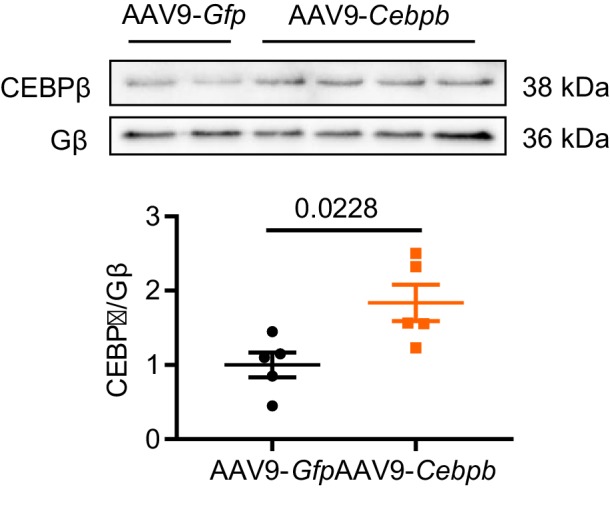
Myocardial CEBPβ expression level after AAV9-Cebpb tail vein injection.Immunoblots and quantification determined that overexpression of ectopic CEBPβ at a physiological range was achieved by AAV9-Cebpb injection (N = 5 mice). Data presented as mean ± SEM. Groups were compared using two-tailed Student’s t-test.Figure 6—figure supplement 1—source data 1.Myocardial CEBPβ expression level after AAV9-Cebpb tail vein injection.